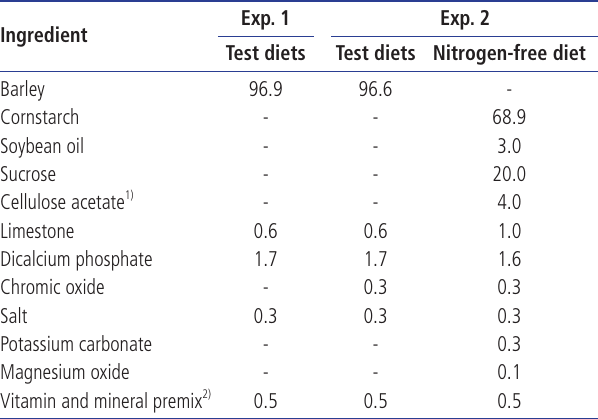
Table 2. Ingredient composition of the experimental diets (% as-fed